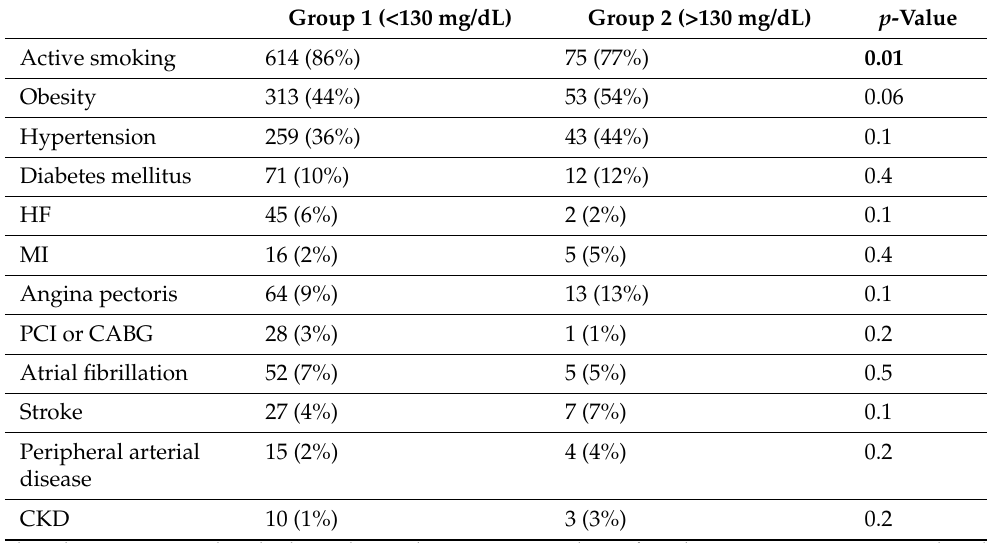
Table 1. Atherosclerosis risk factors and comorbidities in the low versus high Apo B groups.